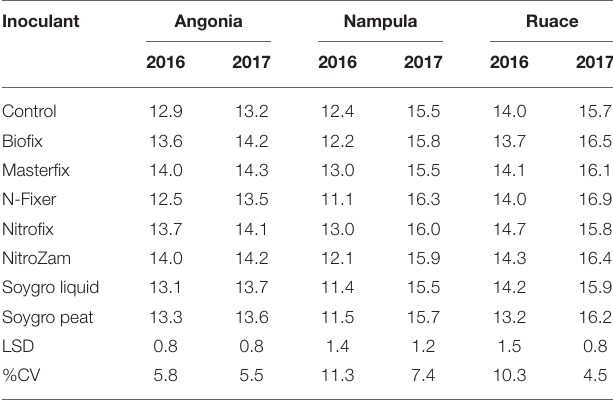
TABLE 6 | 100-Seed weight (g) of inoculants during the 2016 and 2017 growing seasons at three sites Angonia, Nampula, and Ruace.